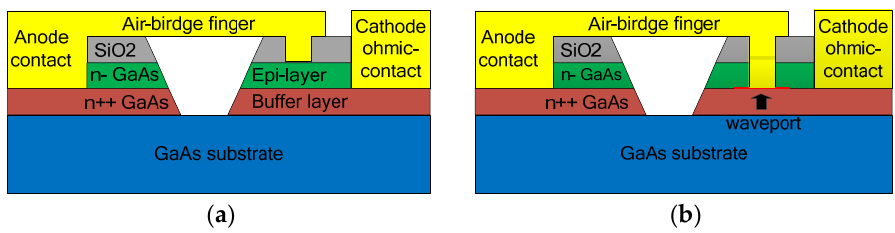
Figure 5. ( a ) A 3D structure model of a planar Schottky diode. ( b ) Schematic diagram of internal wave port setting [35].